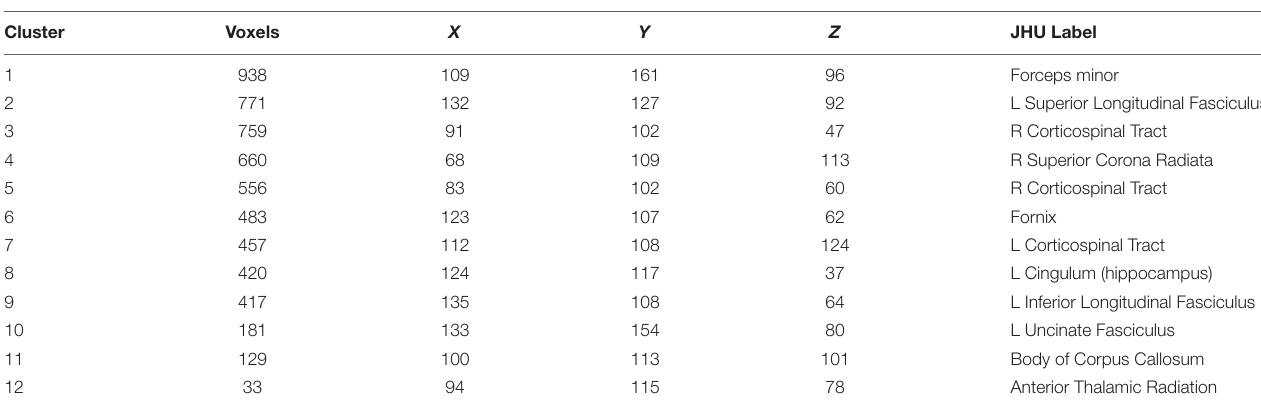
TABLE 3 | Cluster information from the TBSS analysis for income-to-needs ratio